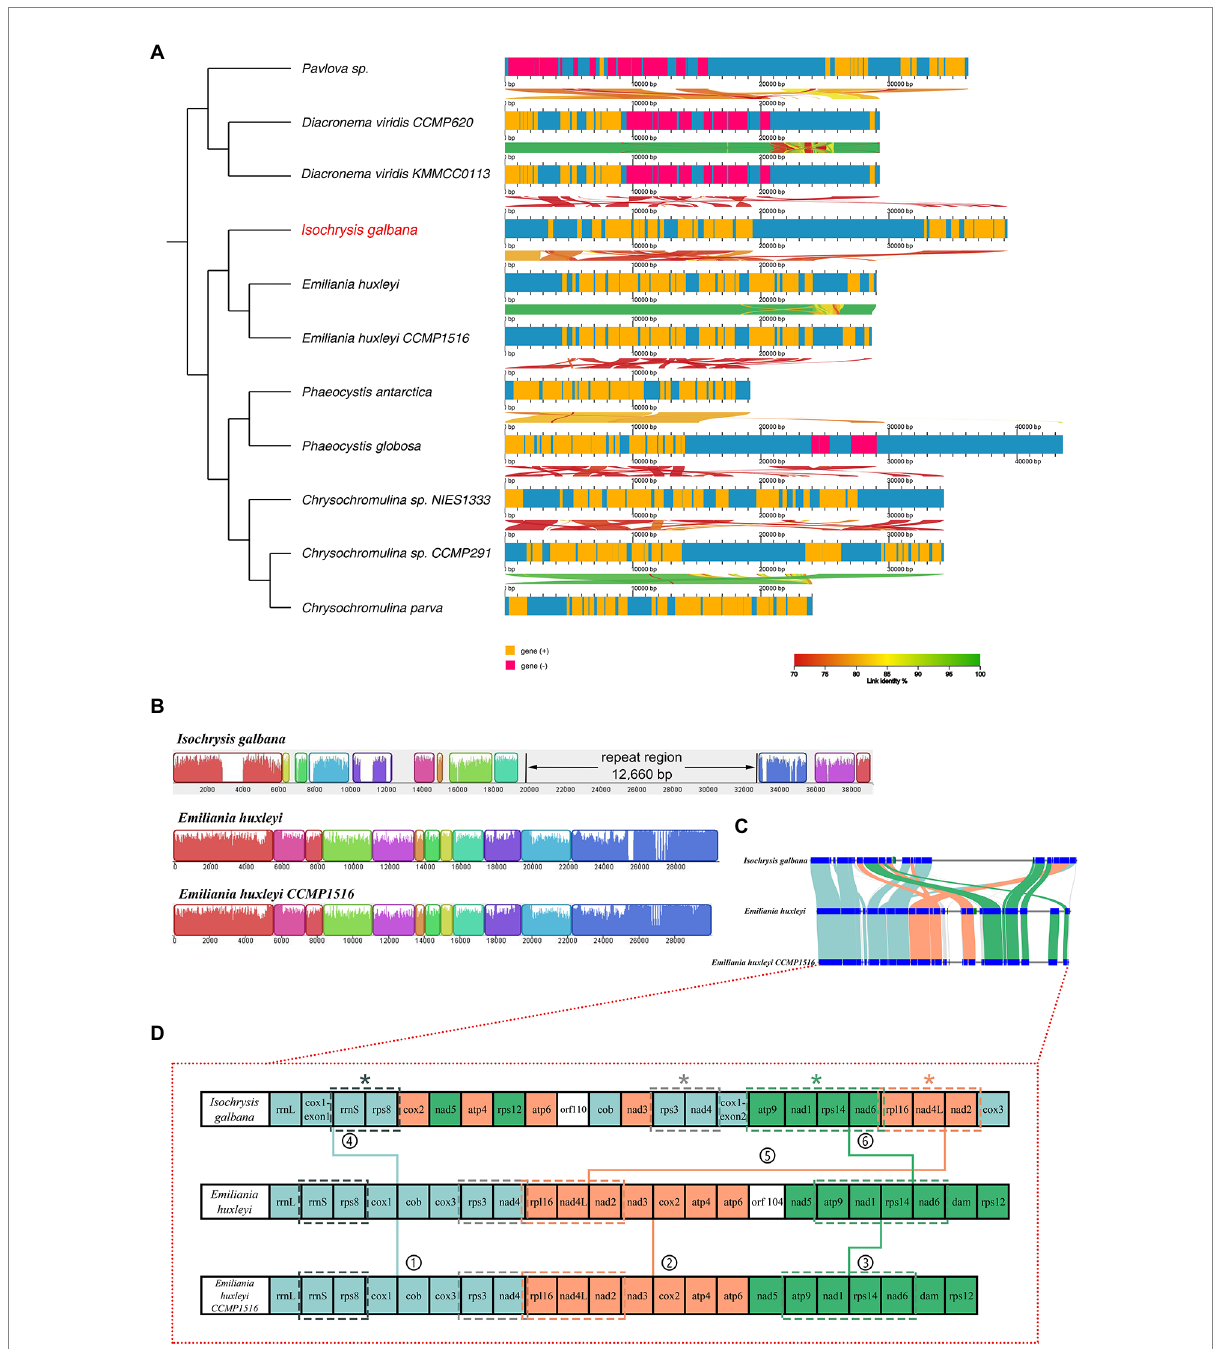
FIGURE 2 Syntenic comparisons of haptophyte mitochondrial genomes. (A) Syntenic comparisons of linear mitochondrial maps relative to a phylogenetic tree of 11 haptophyte species using AliTV software. Both panels depict pairwise comparisons, expressed as percentage of nucleotide similarity, that connect different homologous genomic regions. The x-axis denotes the site of the feature on the mitochondrial genome. An ML phylogenomic tree constructed with shared single-copy genes from 11 mitogenomes is shown on the left; (B) Gene map comparison of I. galbana and two E. huxleyi species in Isochrysidales order aligned using Mauve. A sequence identity similarity profile is shown inside each block. Three mitochondrial genomes were linearized starting at the large ribosomal operon rrnL gene. The ~12.6 kb tandem repeat region unique to I. galbana mitochondrial genome is shown in its linear map. (C) Synteny comparison of the I. galbana and two E. huxleyi species in Isochrysidales order. Light blue, orange and green color blocks represented three large conserved syntenic clusters of protein-coding genes, each cluster containing identical gene order among three species. (D) Gene content and arrangement of three Isochrysidales species. Three large synthetic blocks of protein-coding genes are represented as light blue, orange and green colors, respectively and indicated with numbers (1–6). Four conserved tandem gene clusters consisting of 2–4 genes among three species marked with